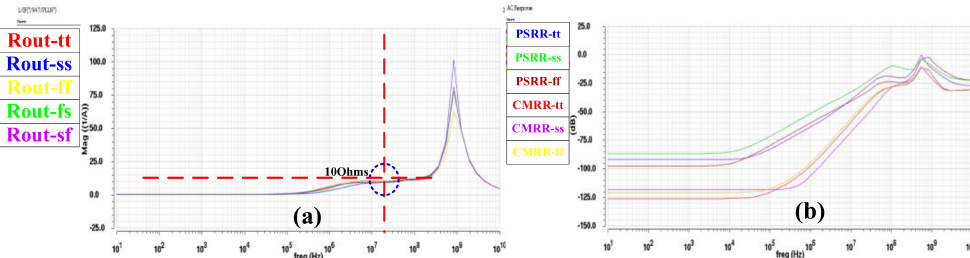
Figure 17. The simulation results of output impedance, power-supply rejection ratio (PSRR), and common-mode rejection ratio (CMRR). ( a ) The output impedance ( b ) PSRR & CMRR.